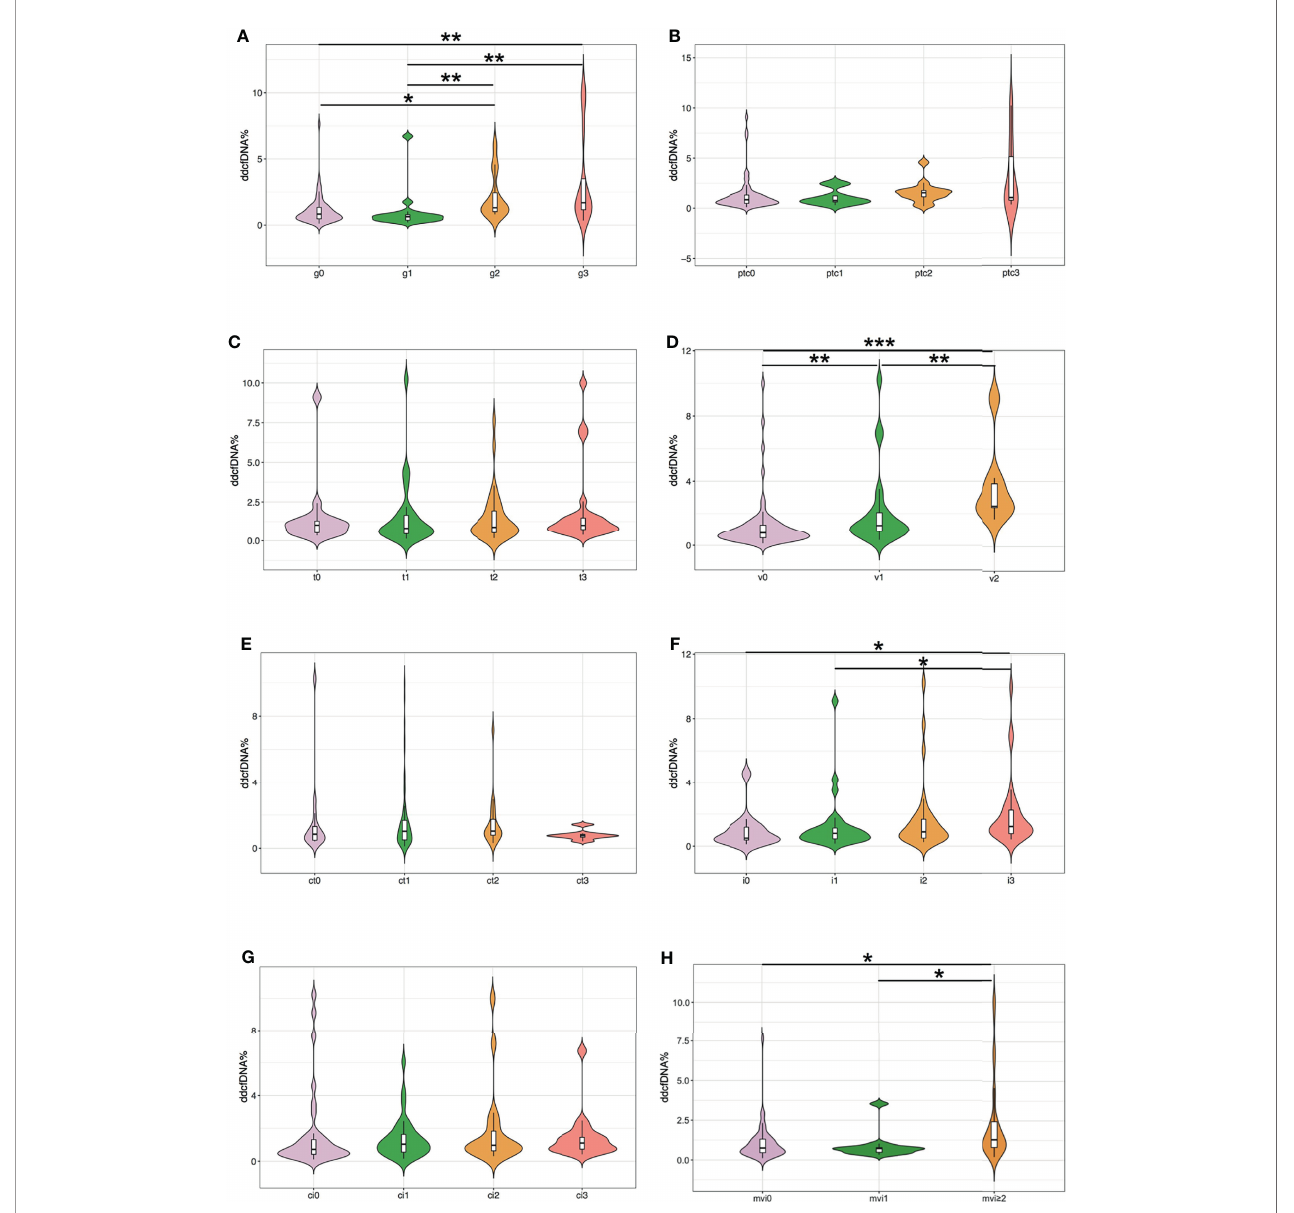
FIGURE 2 | Plasma ddcfDNA fractions in kidney transplant recipients with different Banff lesion scores. (A) Glomerulitis (g); (B) peritubular capillaritis (ptc); (C) tubulitis (t); (D) intimal arteritis (v); (E) tubular atrophy (ct); (F) interstitial in fl ammation (i); (G) interstitial fi brosis (ci); and (H) microvascular in fl ammation (mvi, g+ptc). Violin plot with bold line represents median levels and box indicating the interquartile range. * P < 0.05, ** P < 0.01, and *** P <